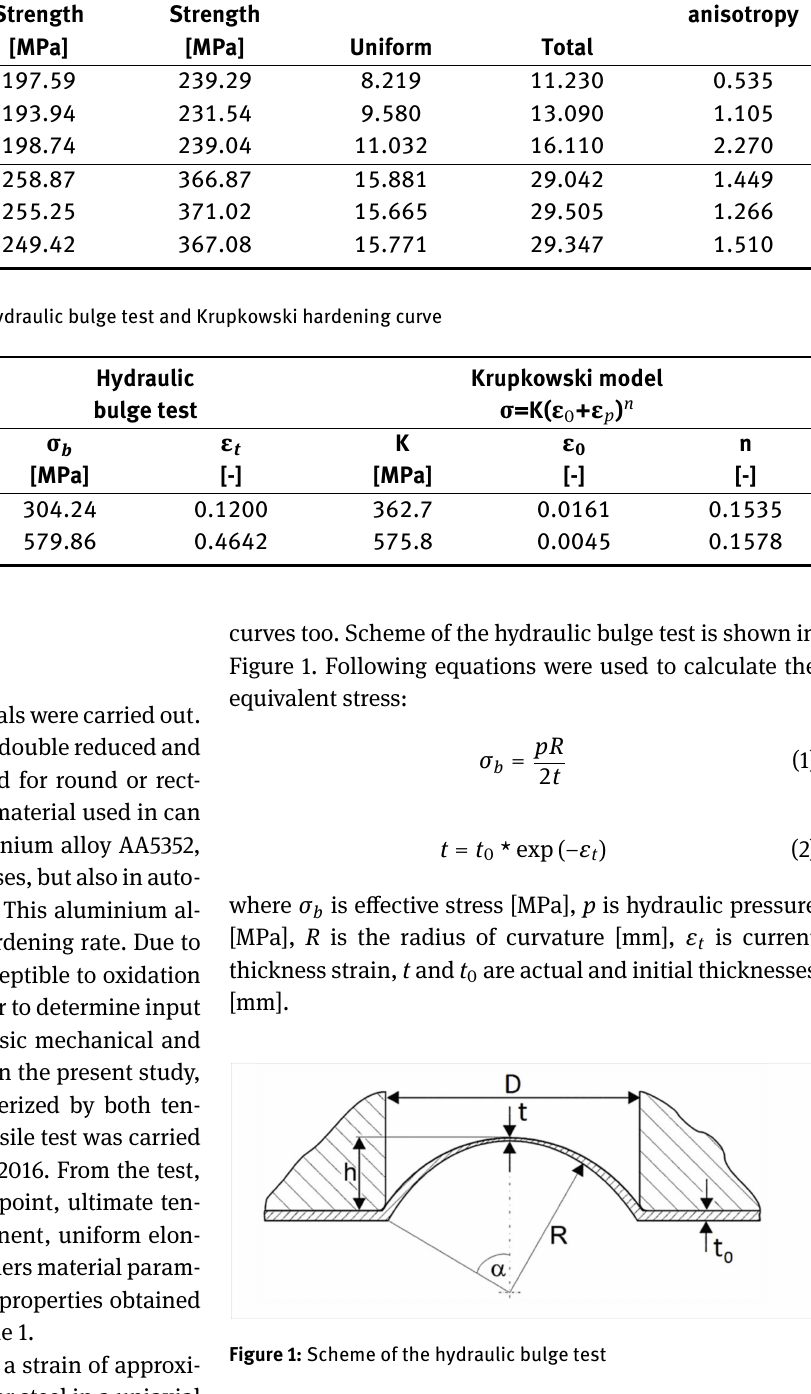
Using values from hydraulic bulge test the strain- hardening curve can be established. The parameters for determination of hardening curve and results of hydraulic bulge test are shown in Table